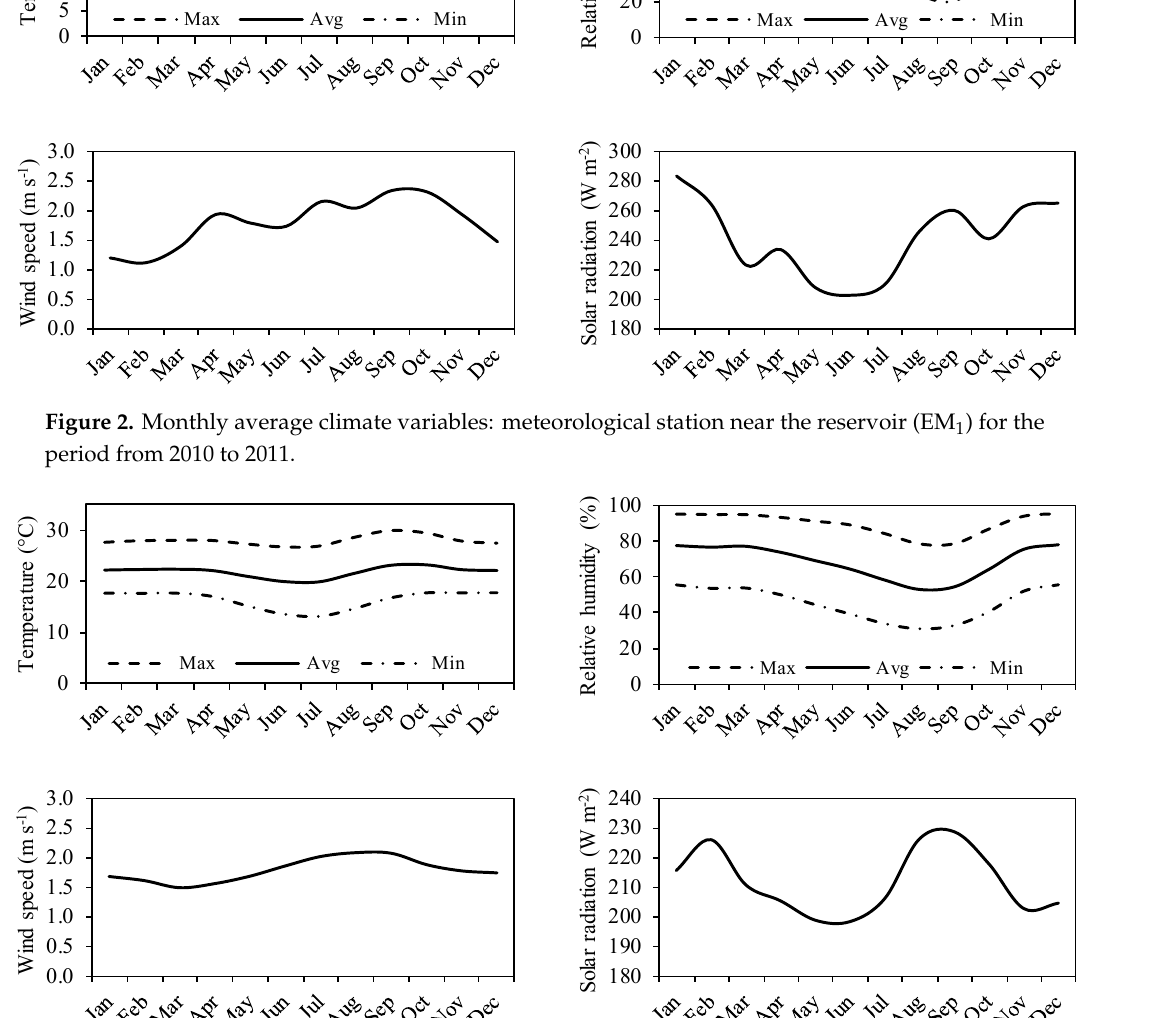
Figure 3. Monthly average climate variables: meteorological station EM 2 for the period from 1974 to 2017.